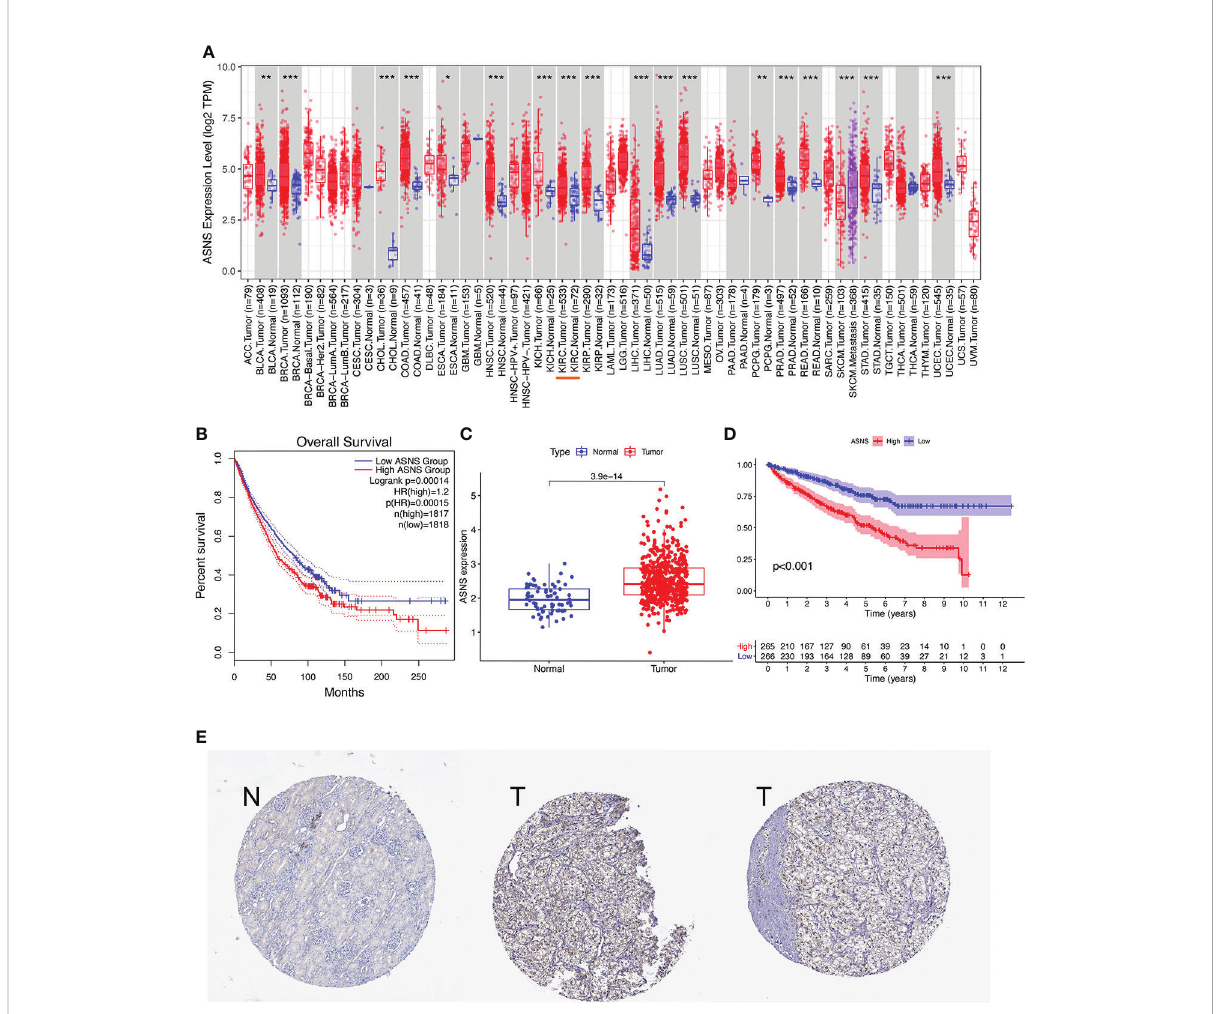
FIGURE 1 Expression of ASNS . (A) Pan-cancer expression of ASNS . (B) Prognostic values of ASNS gene in multiple cancers (BRCA, CESC, CHOL, ESCA, KIRC, LIHC, LUAD, LUSC, PAAD, and STAD). (C) ASNS expression in ccRCC and normal tissues. (D) Relationship between ASNS expression levels and prognosis, i.e., overall survival (OS). (E) ASNS protein level in ccRCC from the HPA database. The statistical signi fi cance computed by the Wilcoxon test is annotated by the number of stars (*: p-value <0.05; **: p-value <0.01; ***: p-value